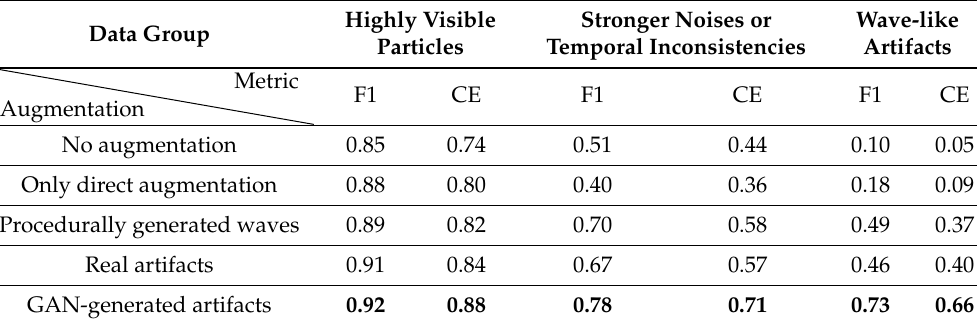
Table 3. F1-score (F1) and count exactness (CE) values for samples containing particles of interest after training with different augmentation methods broken down by dominant artifact types. The best results are written in bold.